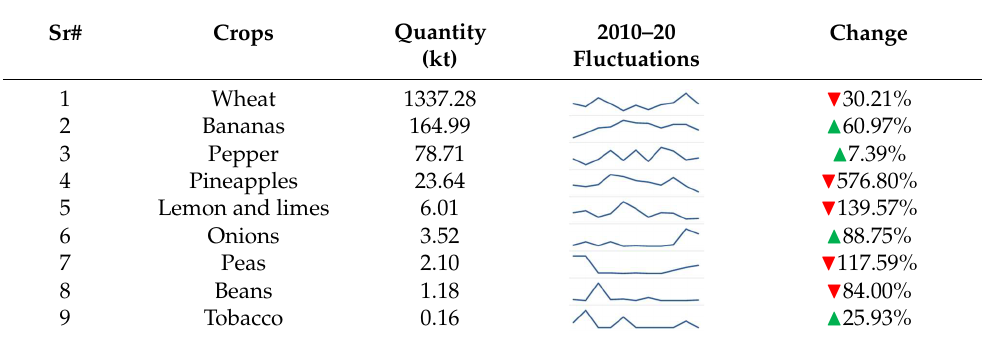
Table 3. Top nine exports of Sri Lankan crops based on last eleven years (2010–2020),( ▲ Positive change in import of crops from 2010-2020, ▼ Negative change in import of crops from 2010-2020).